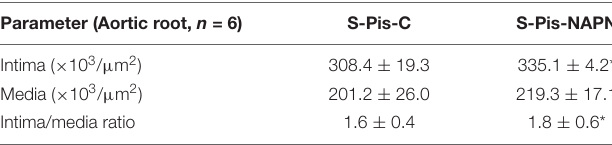
TABLE 6 | Histological characterization of atherosclerotic lesions in the aortic roots of both experimental group mice. Parameter (Aortic root, n =